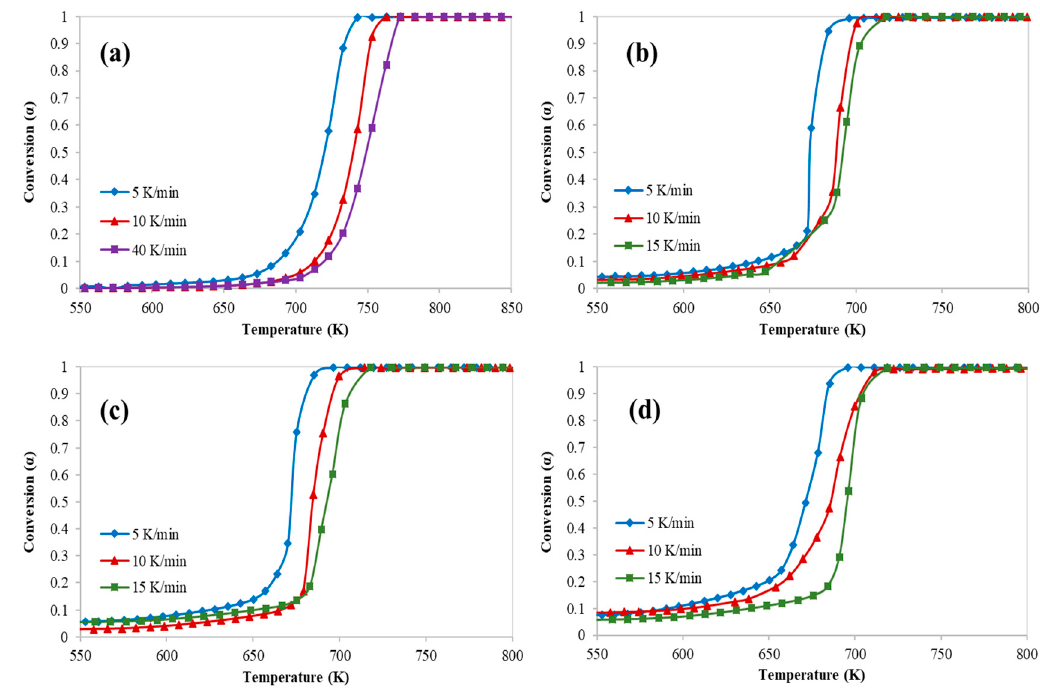
Figure 3. Conversion curves of catalytic pyrolysis of HDPE at different catalyst to polymer mass ratio: ( a ) 0, ( b ) 0.5, ( c ) 0.77, and ( d ) 1 .